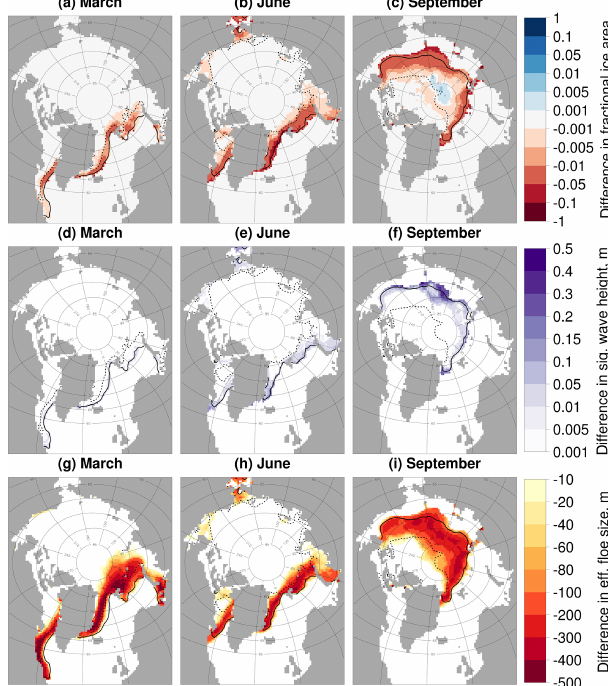
Figure 12. Difference in the sea ice concentration (a–c) , signif- icant wave height (d–f) and l eff (g–i) for (J), with the wave at- tenuation rate reduced by 90%, compared to stan-fsd, both using standard FSD parameters. Plots show results for March (a, d, g) , June (b, e, h) , and September (c, f, i) averaged over 2007–2016. Each plot shows the inner (dashed black) and outer (solid black) extent of the MIZ averaged over the same period. Values are shown only in locations where the sea ice concentration exceeds 5%. The plots show that despite very small differences in the significant wave height, the reduced attenuation rate still drives reductions in l eff and in consequence the sea ice concentration across the